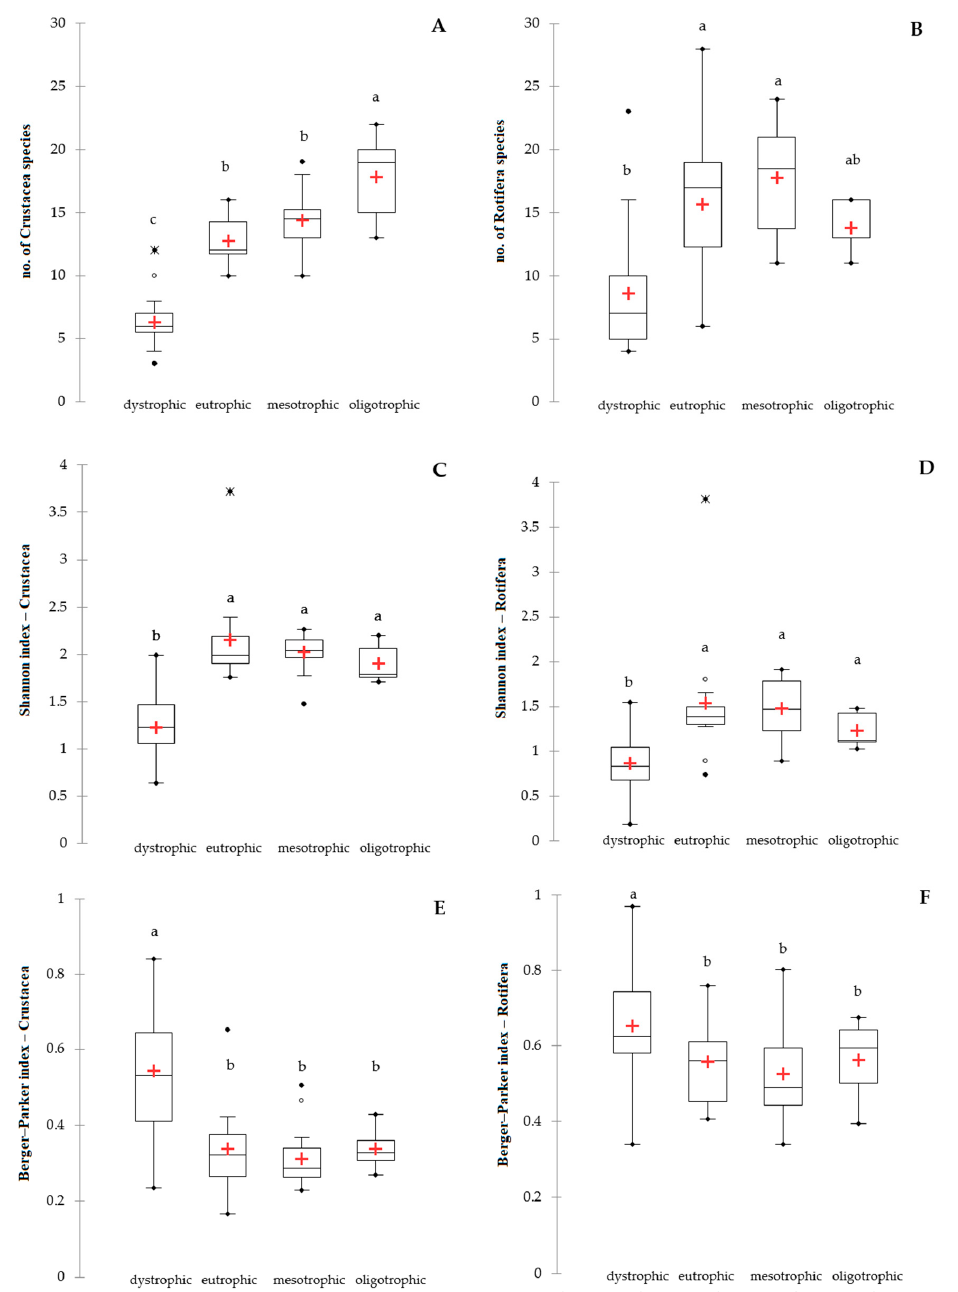
Figure 2. Diversity of crustacean ( A , C , E ) and rotifer ( B , D , F ) communities in different trophic conditions presented as an average number of species ( A , B ), Shannon index ( C , D ) and Berger–Parker dominance index ( E , F ). The lower and upper limits of the boxes are the first and third quartiles, respectively. The crosses correspond to the means and the central horizontal bars are the medians. Points above or below the whiskers are the outliers and extreme values. The different letters (a, b, c) above the box plots denote significantly different values at p < 0.05; the same letters denote no statistically significant differences.